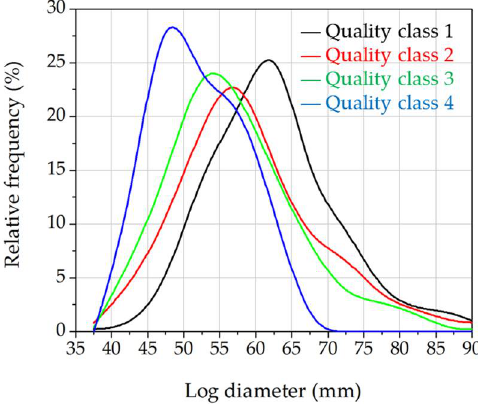
Figure 7. Frequency distribution of diameter of spruce logs from various quality classes (Q 1 and Q 2 —veneer log quality, Q 3 and Q 4 —sawlog quality). Q 2 —veneer log quality, Q 3 and Q 4 —sawlog quality).